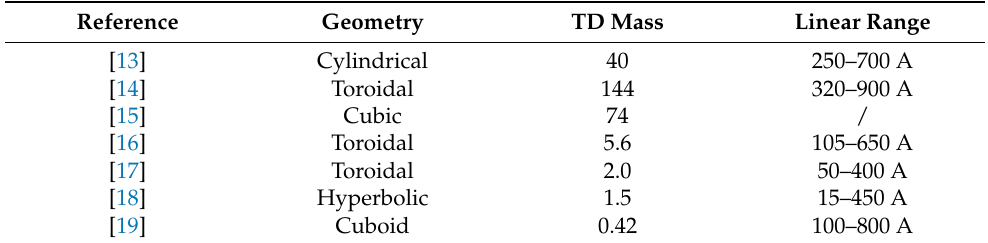
Figure 13. Optical fiber current sensor based on 0.42 g cuboid magnetostrictive composite mate- rial. Table 1. Comparison: FBG-based current sensorsfor high-voltage lines.